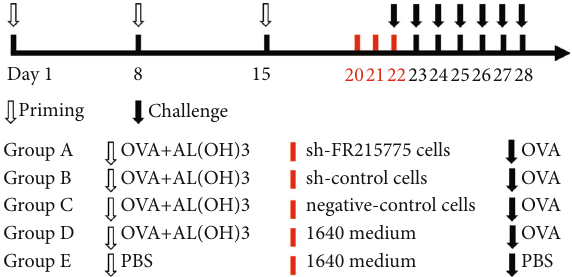
Figure 1: Schematic diagram of AR mice model